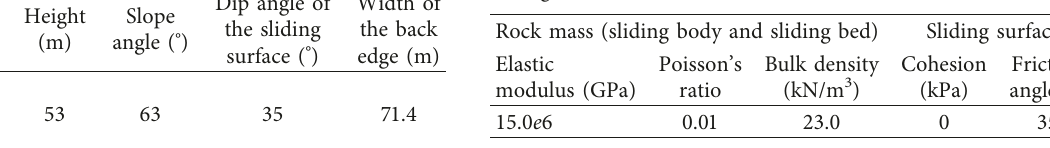
Table 2: Geometric parameters of slope. Table 3: Physical and mechanical parameters of rock mass and sliding